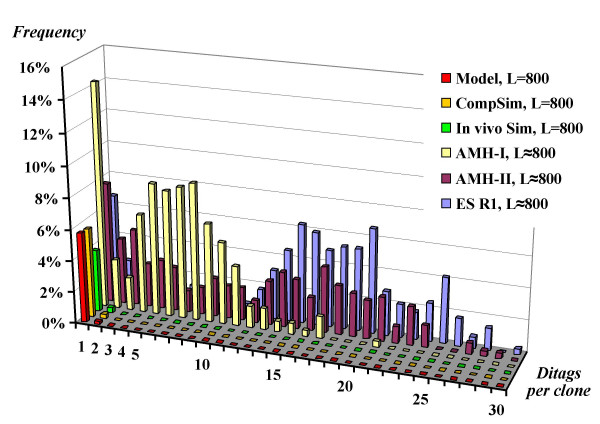
Frequency distribution of the number of ditags in SAGE output. Probability to find various numbers of ditags in the clone sequence has been plotted as a function of a number of total ditags per clone. Model, mathematical modeling; CompSim, computer simulation (1,000,000 simulations); In vivo Sim, fragments of S. Cerevisiae chromosome (300 simulations); AMH-I, -II, ES R1, actual SAGE data (sequences from 3 randomly chosen 96-well plates). Sequence length (L) = 800 bp for Model, CompSim and In vivo Sim; average sequence length ≈ 800 bp for all three SAGE libraries.